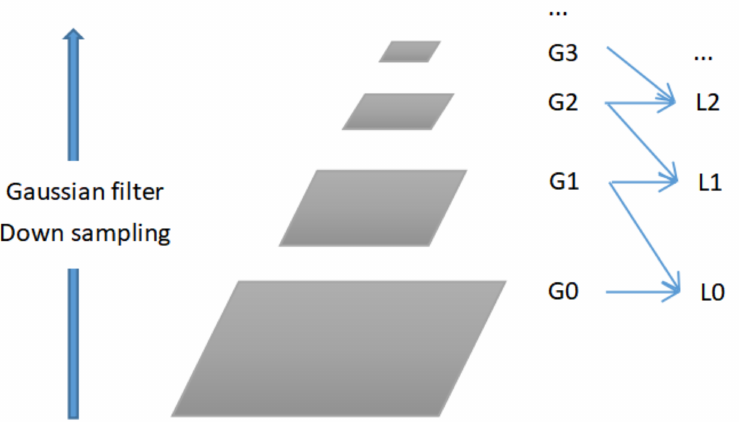
Figure 3. Laplace Pyramid Structure. G0, G1, G2, G3 are the Gaussian pyramid images. In a Gaussian pyramid, subsequent images are weighted down using a Gaussian average and scaled down. L0, L1, L2 are the Laplace pyramid images which save the difference image of the Gaussian images between each